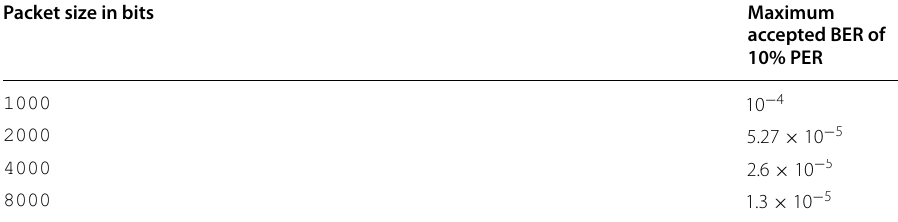
Table 1 The corresponding BER values of 10% PER for various packet sizes Packet size in